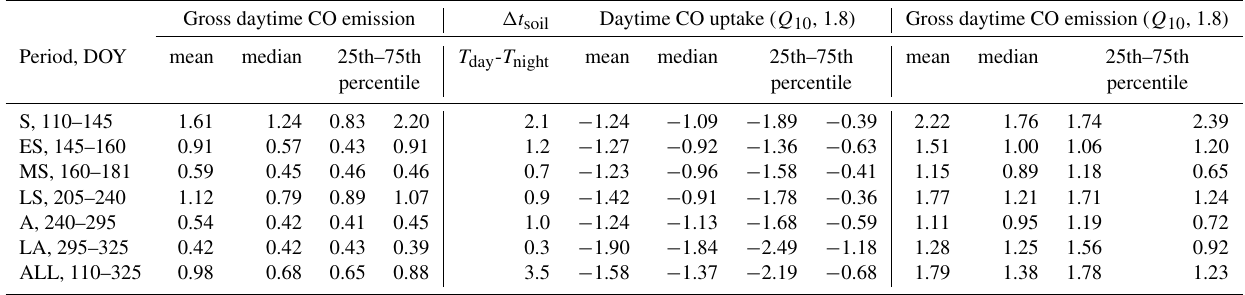
Table 2. Mean, median and 25–75th percentiles of the estimated gross daytime CO emission (gross daytime CO emission, nmolm − 2 s − 1 ) , temperature-corrected daytime CO uptake (daytime CO uptake; Q 10 1.8) and temperature-corrected gross daytime CO emission (gross daytime CO emission; Q 10 1.8) calculated for the read canary grass (RCG) crop at Maaninka. The CO emission and uptake rates are calculated for six measurement periods (S is spring, ES is early summer, MS is midsummer, LS is late summer, A is autumn, LA is late autumn) and over the full measurement period (all) from April to November 2011. The estimated gross daytime CO emission is calculated in two ways: (1) assuming a constant CO uptake and (2) assuming temperature-dependent CO uptake. Gross daytime CO emission based on a constant CO uptake (way 1, Sect. 2.4) refers to the difference between daytime fluxes ( F CO_day ) and night-time fluxes ( F CO_night ) presented in Table 1. The temperature-corrected gross daytime CO emission (gross daytime CO emission; Q 10 , 1.8) refers to the difference between daytime fluxes ( F CO_day ; Table 1) and daytime CO uptake ( Q 10 , 1.8). The daytime CO uptake (daytime CO uptake; Q 10 , 1.8) is calculated by extrapolating the night-time CO fluxes ( F CO_night ) to daytime using the difference between day and night soil temperatures (2.5cm depth; (cid:49)t soil ) and the Q 10 value of 1.8 (Whalen and Reeburgh, 2001), as described in Sect. 2.4. Gross daytime CO emission (cid:49)t soil Daytime CO uptake ( Q 10 , 1.8) Gross daytime CO emission ( Q 10 ,